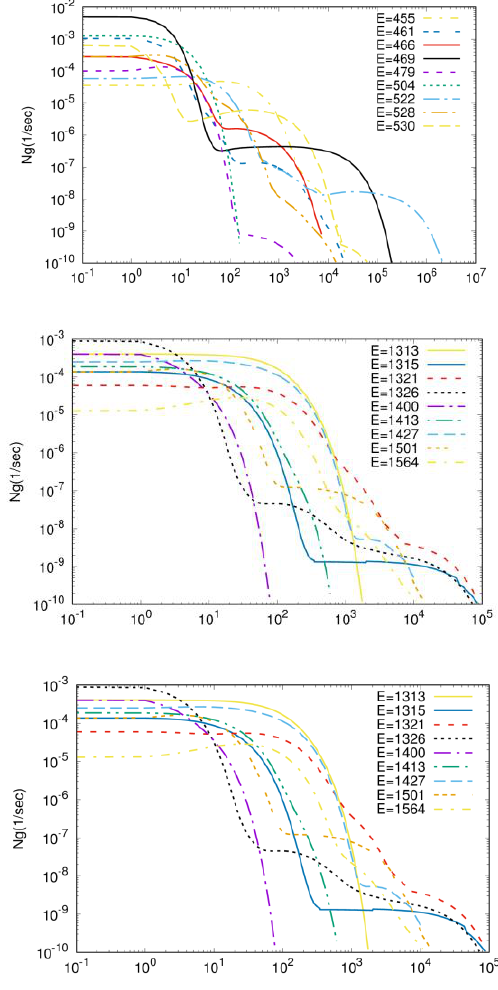
The beta delayed fission gamma spectra of n+ 241 Pu are calculated with incident neutron of thermal and fission spectrum. Part of the results of n th + 241 Pu are shown in Fig.6, which counts (coefficients) are larger than 0.001 at variant energy regions around 500, 1000, 1500 and 2000 keV. There are about 50 coefficients are large than 0.01 and listed in Table.